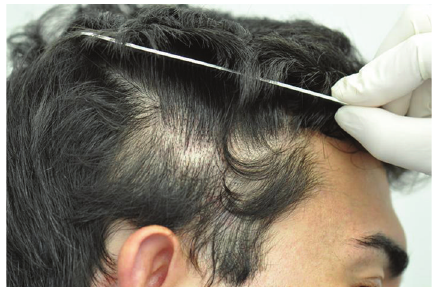
Figure 9: Right side with hair